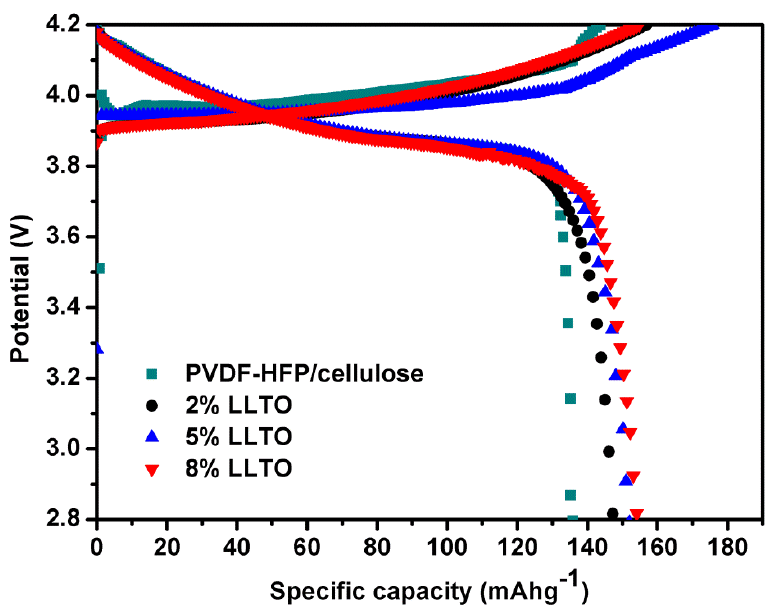
Figure 8. Charge ‐ discharge characteristics of cells containing various separators at first cycle. Figure 8. Charge-discharge characteristics of cells containing various separators at first